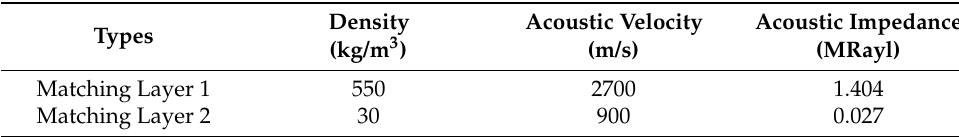
Figure 1. Schematic diagram ( a ) and physical diagram ( b ) of air-coupled ultrasonic transducer. Table 1. Physical parameters of the matched material.